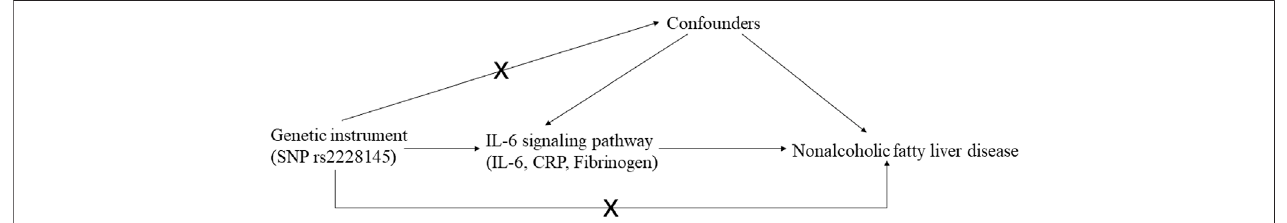
FIGURE 1 | The basic assumptions and main design of this Mendelian randomization.